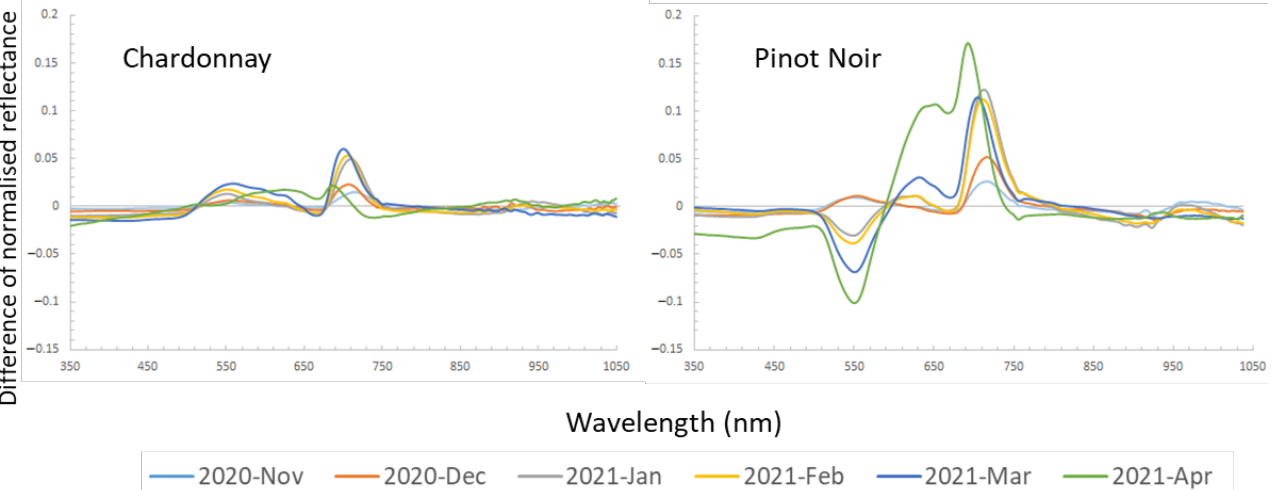
Figure 5. The difference of normalised averaged spectral reflectance of diseased to healthy vines (value at 0) for each timepoint.